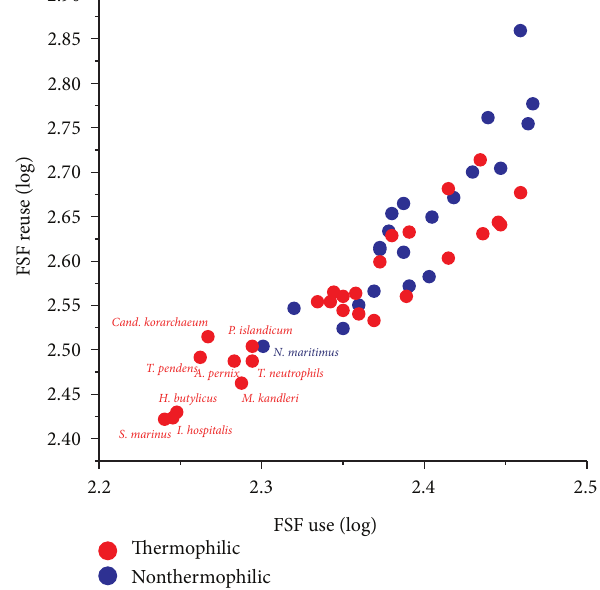
Figure 7: A plot of FSF use (diversity) against FSF reuse (abun- dance) reveals a linear pattern of proteomic growth in 48 archaeal proteomes. Thermophilic archaeal species occupy positions that are close to the origin of the plot. They also populate the most basal branch positions in ToLs (see discussion in the main text). Both axes are in logarithmic